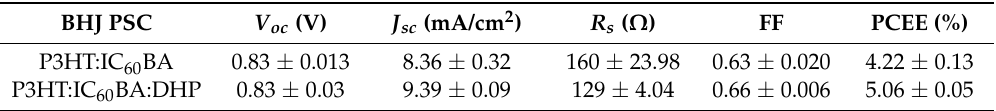
Table 1. Summary of the photovoltaic performance parameters of the BHJ PSCs